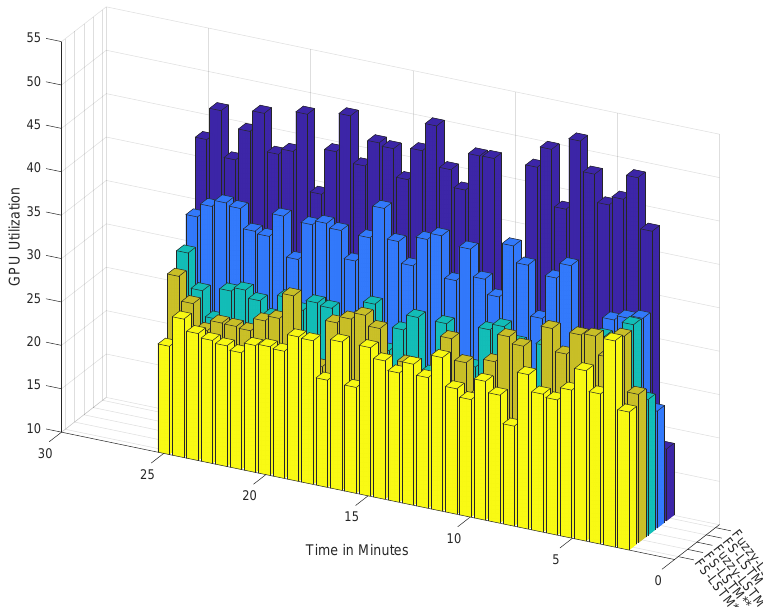
Figure 12. The benchmark of GPU utilization during testing. Fuzzy-LSTM and FS-LSTM networks trained with 32 layers (denoted with *), and a hybrid version of FS-LSTM (denoted with